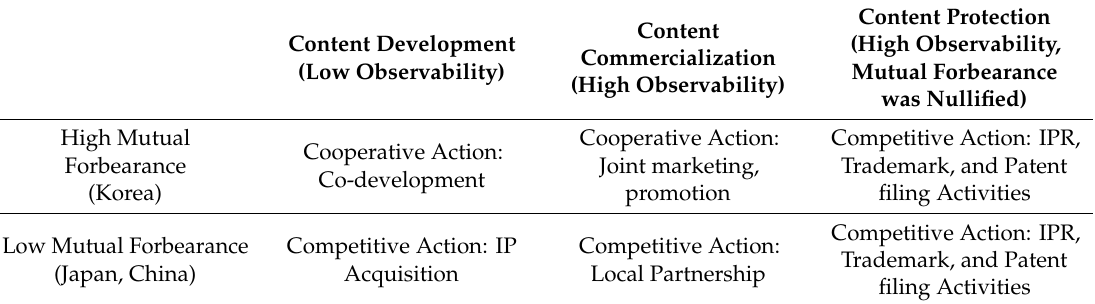
Table 5. Summary of